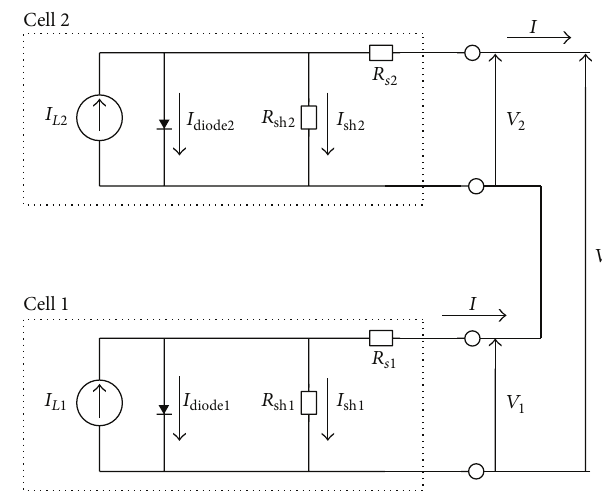
Figure 2: Equivalent circuit of the two cell series.